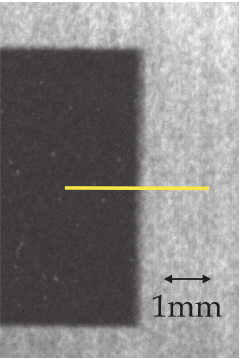
Figure 8. Image of a Cd edge, thickness 0.5 mm, neutron wavelength λ = 0.32 nm, exposure time = 1800 s, beam divergence φ = 0.1 ◦ ∼ L/D = 573,